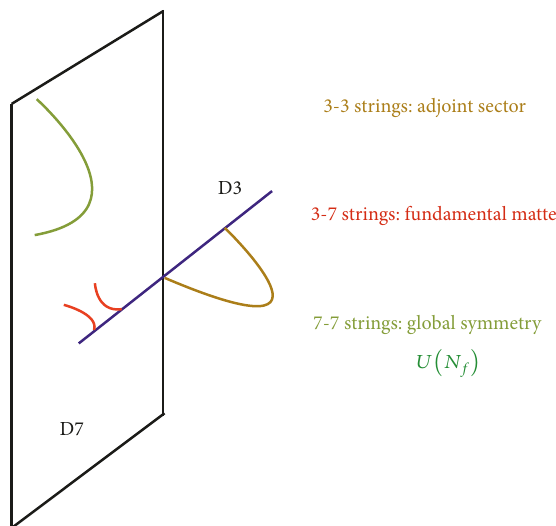
Figure 4: A schematic presentation of a generic D-brane con- struction. A certain 𝑁 number of D 3 -branes, 𝑁 푓 number of D 7 - branes, before taking the decoupling limit. The low energy degrees of freedom can be simply obtained by considering string spectrum. The 3 − 3 strings yield the matter content of N = 4 SYM, the 3 − 7 and 7−3 strings yield the N = 2 hypermultiplet, and the 7−7 string sector is nondynamical; i.e., it yields a global